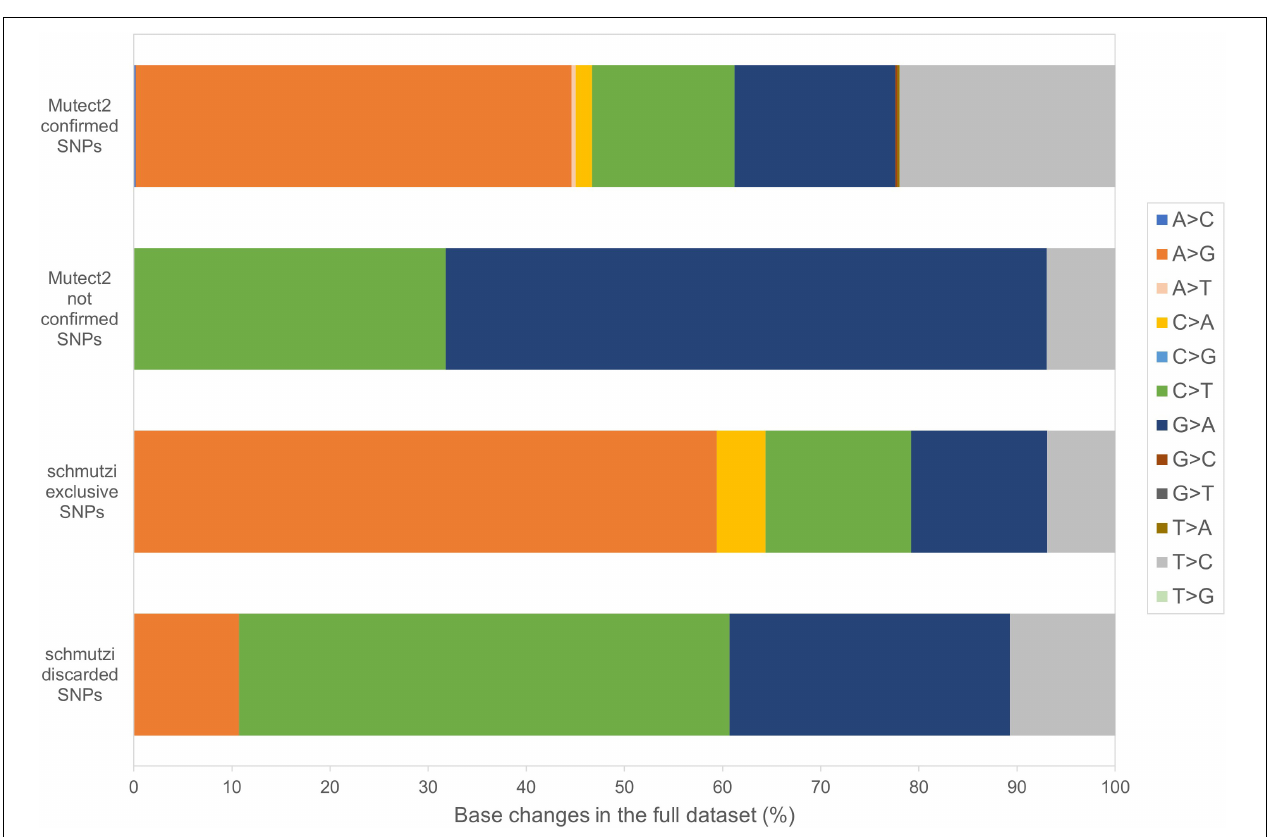
FIGURE 5 | Base changes composition in Mutect2 and schmutzi variants. All the possible base changes were quantified for the whole dataset considering variants detected by Mutect2, reliable according to our filtering pipeline, confirmed by both methods (Mutect2 and schmutzi), those exclusively detected by one or the other, and schmutzi variants we discarded (detected by Mutect2 but not passing